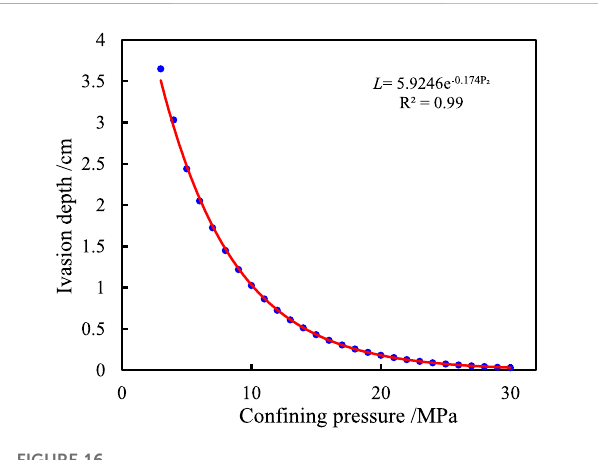
FIGURE 16 Relationship between the invasion depth of the drilling fl uid along the bedding fracture and con fi ning